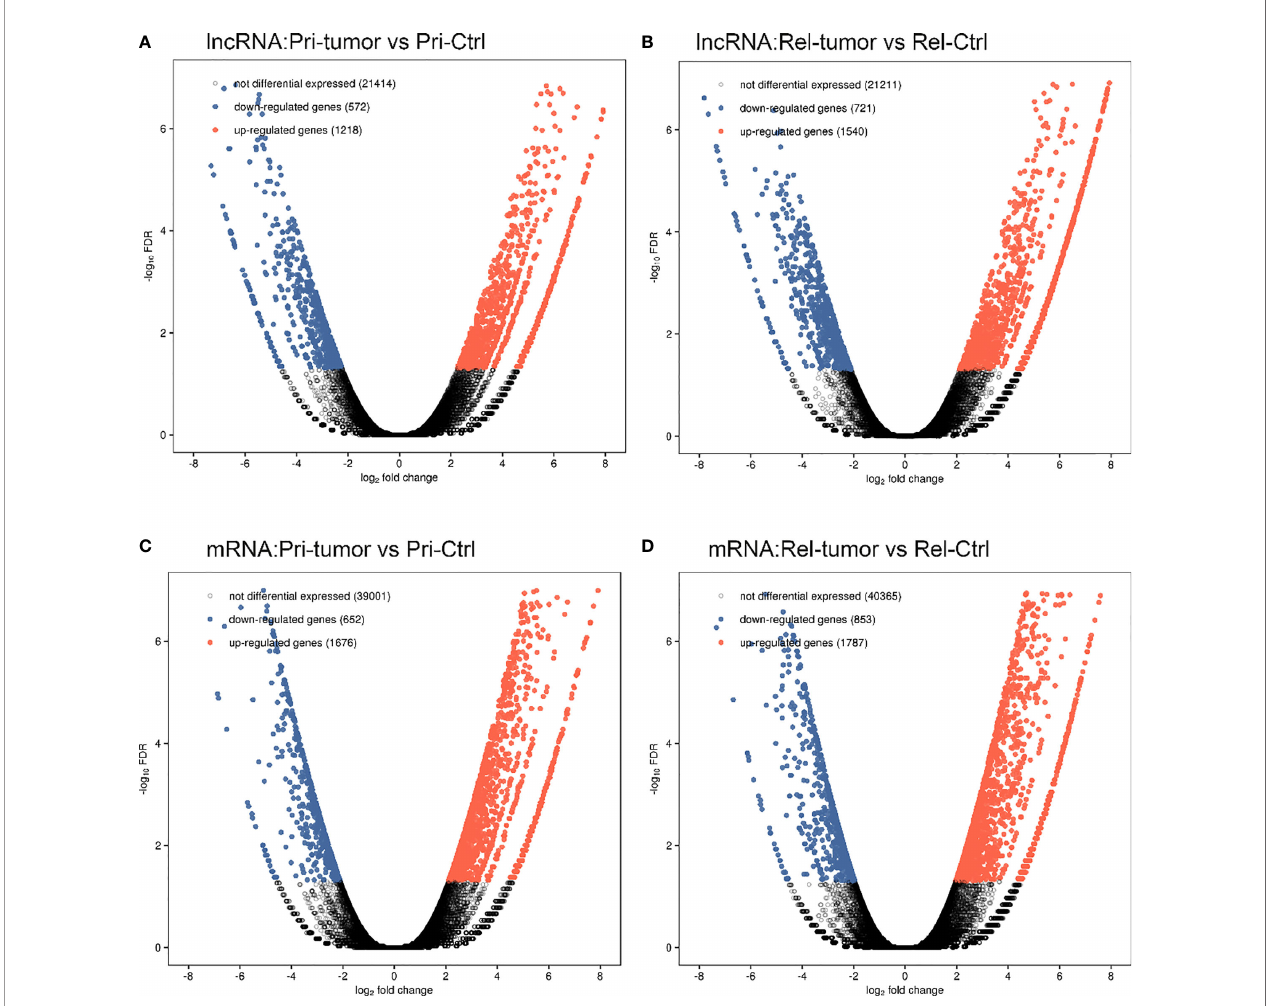
FIGURE 2 | A comprehensive catalog of lncRNA genes in primary tumor, relapse tumor, benign adjacent tissue. (A) Volcano plot of the lncRNAs in primary tumor and benign adjacent tissue. (B) Volcano plot of the lncRNAs in relapse tumor and benign adjacent tissue. (C) Volcano plot of the mRNAs in primary tumor and benign adjacent tissue. (D) Volcano plot of the mRNAs in relapse tumor and benign adjacent